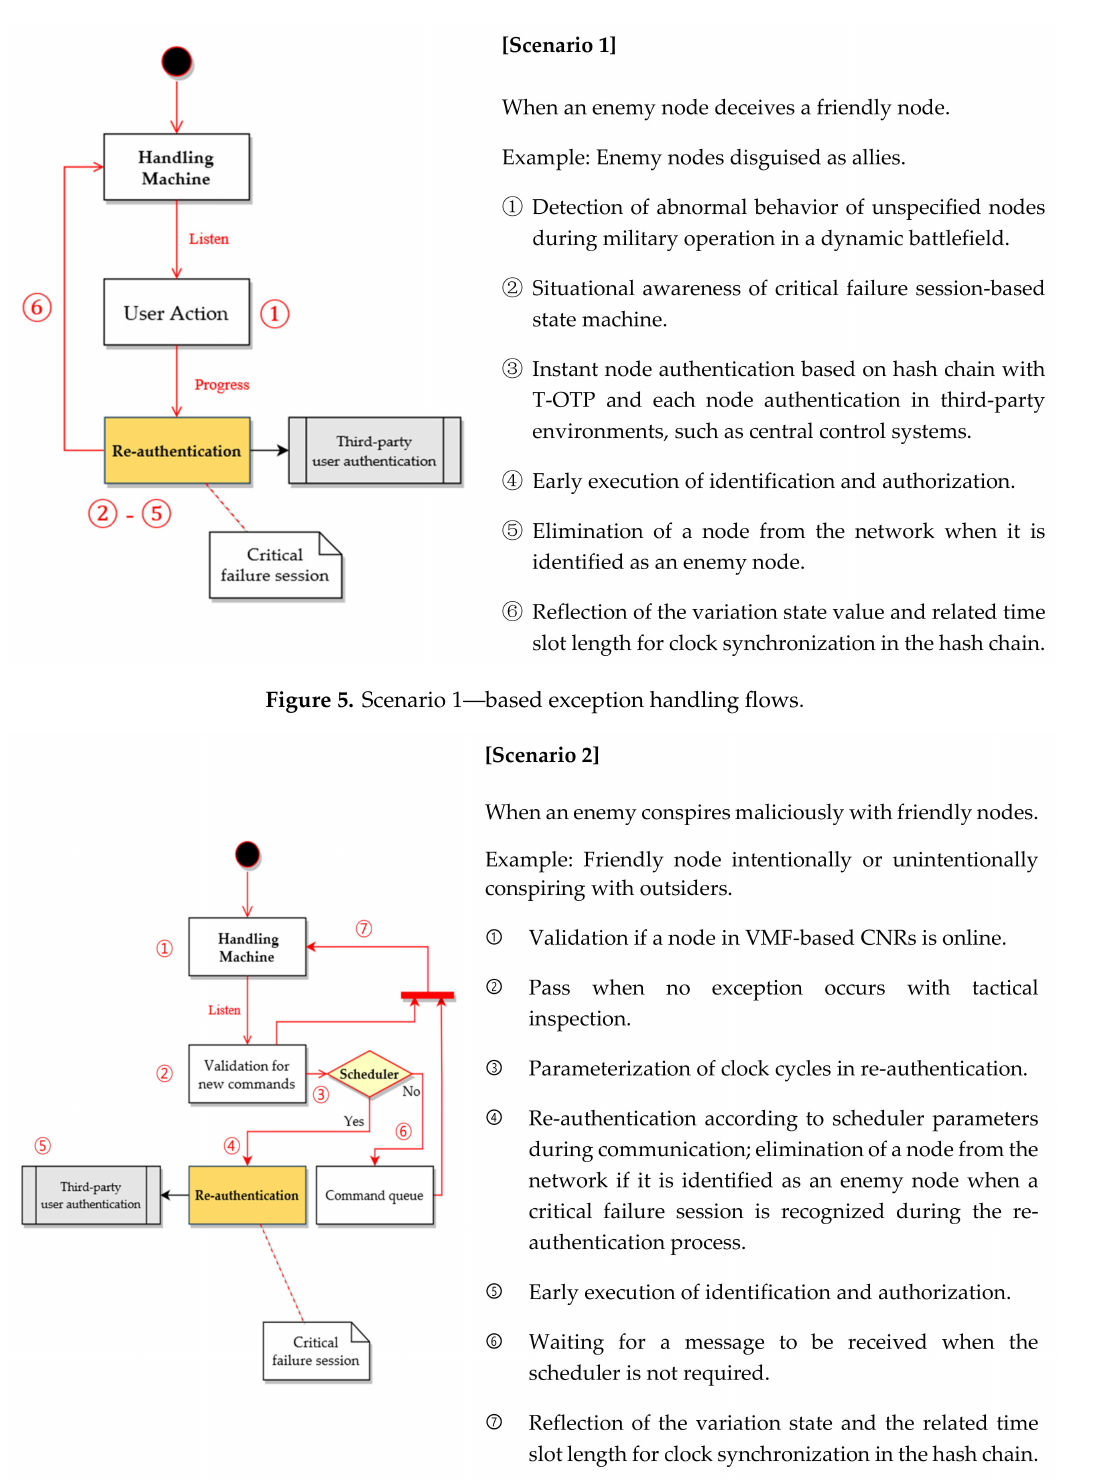
Figure 6. Scenario 2—based exception handling